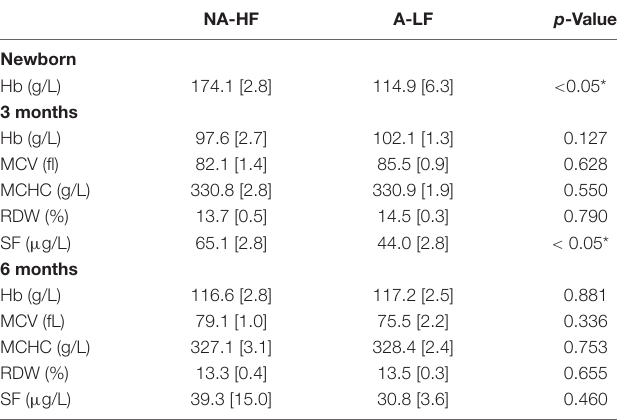
TABLE 2 | Iron status in the NA-HF and A-LF groups.